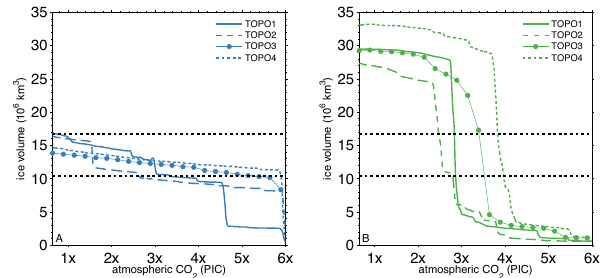
Fig. 7. Transient CO 2 experiments with varying ISM bedrock to- pography. (a) Using climate output from CCSM3_H simulations. (b) Using climate output from GENESIS simulations. The ISM bedrock topographies are shown in Fig. 1.